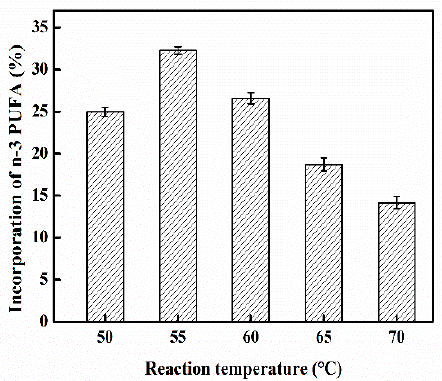
Figure 3. Effects of reaction temperature on the incorporation of n-3 PUFA into PC. Reaction conditions were as follows: n-3 PUFA-rich EE/PC mass ratio of 6:1, enzyme loading of 20% ( w / w ), water dosage of 1% ( w / w ), and reaction time of 24 h under N 2 .